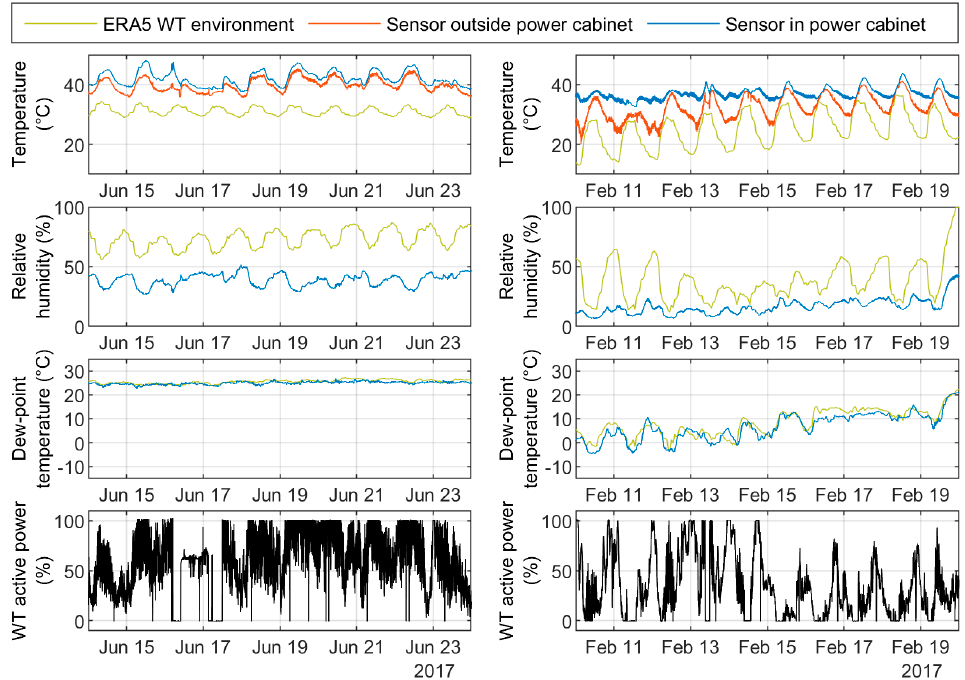
Figure 10. Segments of the measurement and ERA5 data presented in Figure 9 from an onshore wind turbine in India with a liquid-cooled converter located in the tower base.